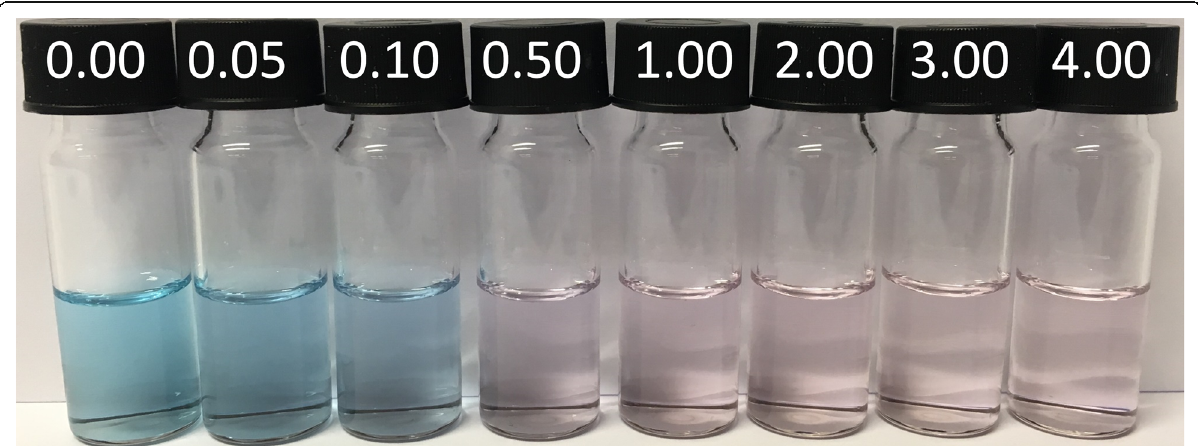
Fig. 5 Color changes observed upon addition of different concentration ( μ M) of Ag + to the solution of probe 1 in HEPES buffer solution (pH 8.0)